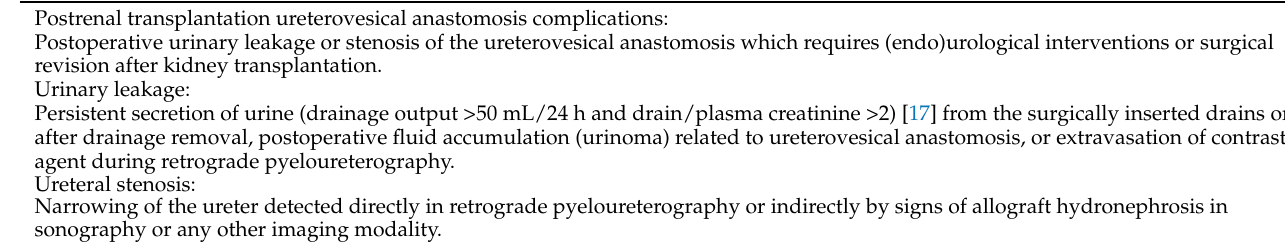
Table 1. Definition and severity grading of postoperative ureterovesical anastomosis complications after kidney transplantation.